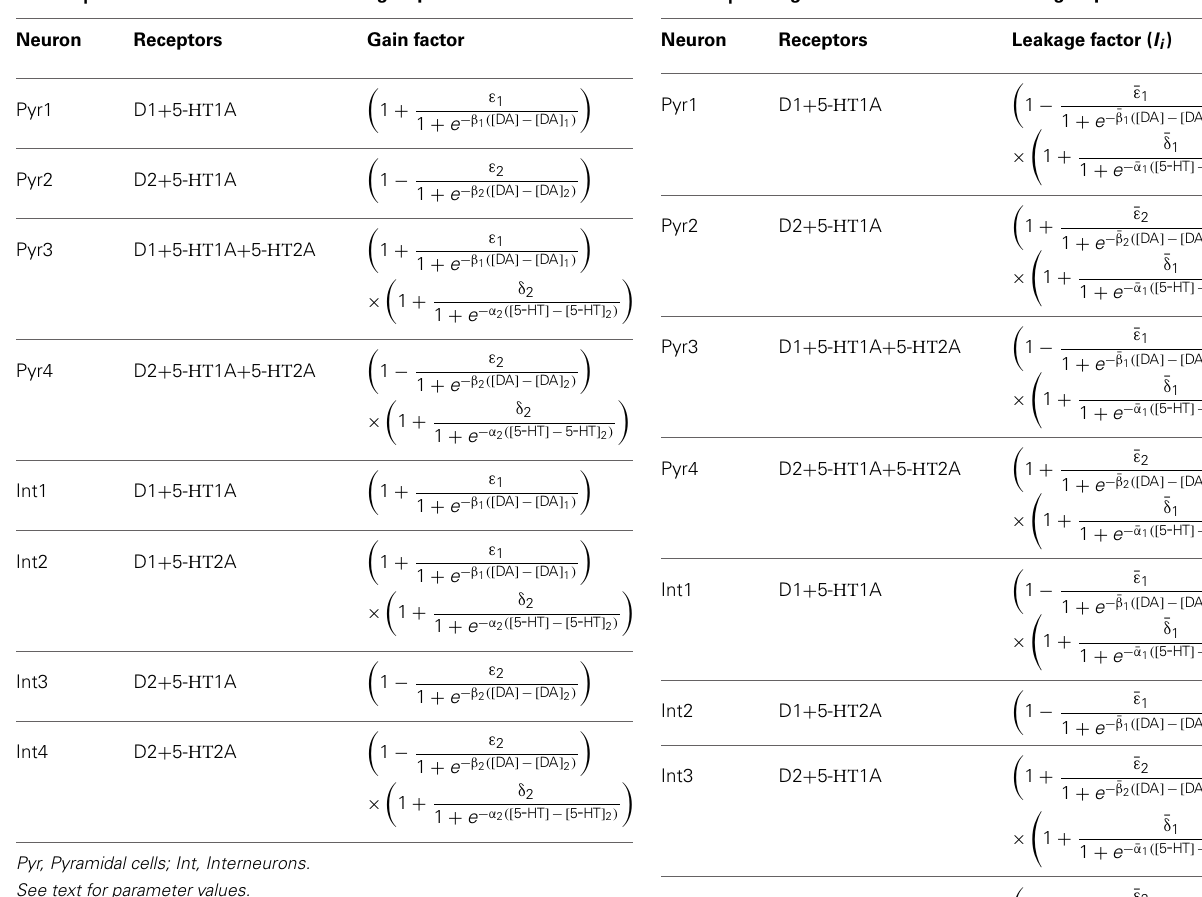
Table 3 | Leakage factor for the neuronal